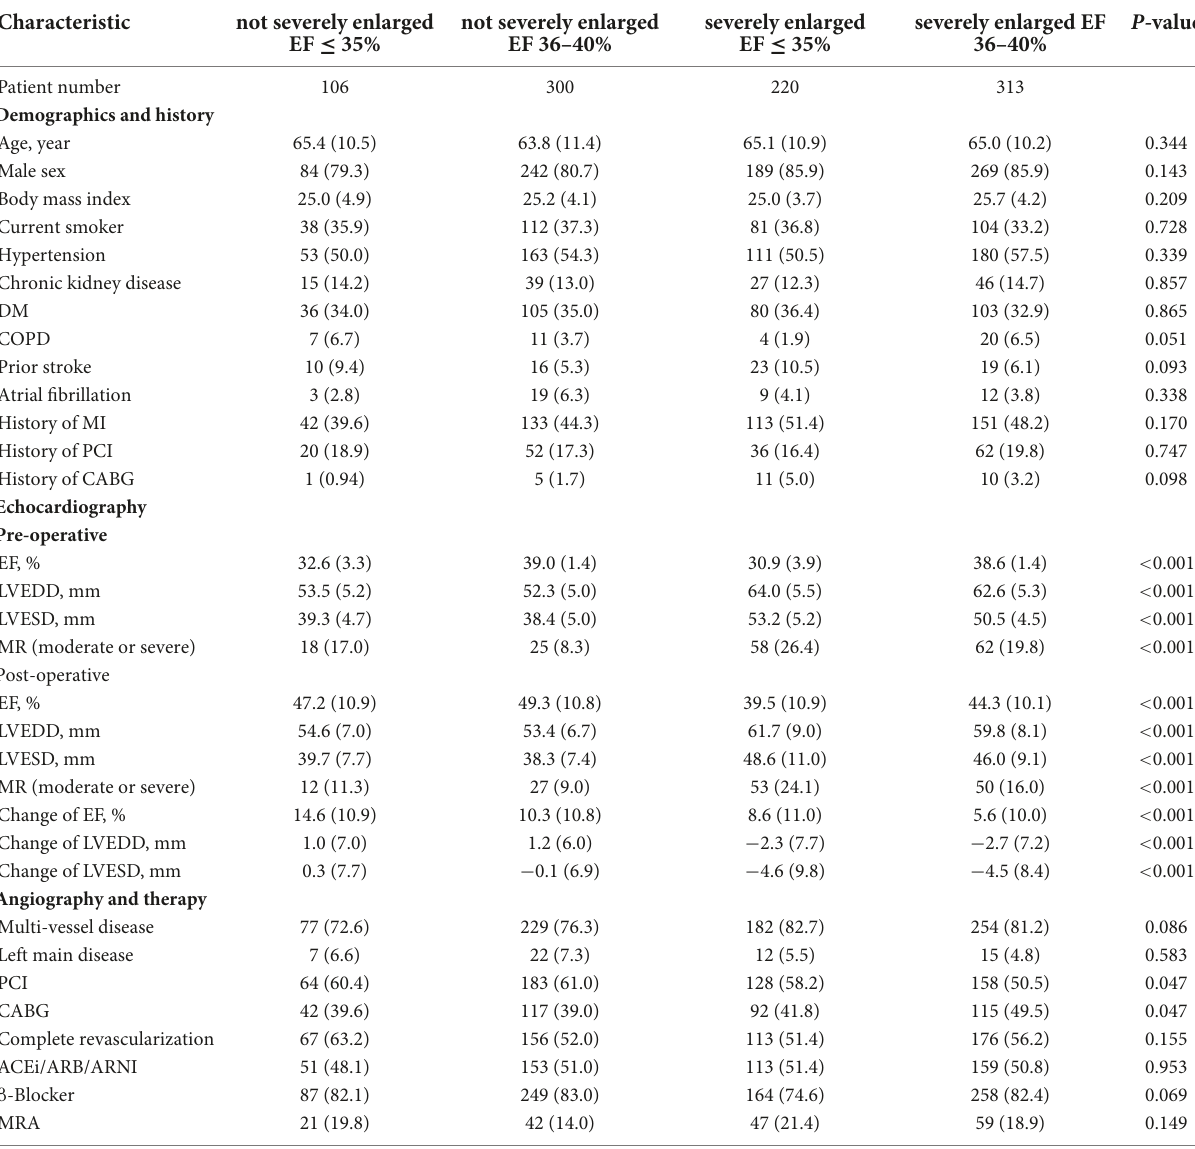
TABLE 2 Patient characteristics according to LVESD and EF at baseline a